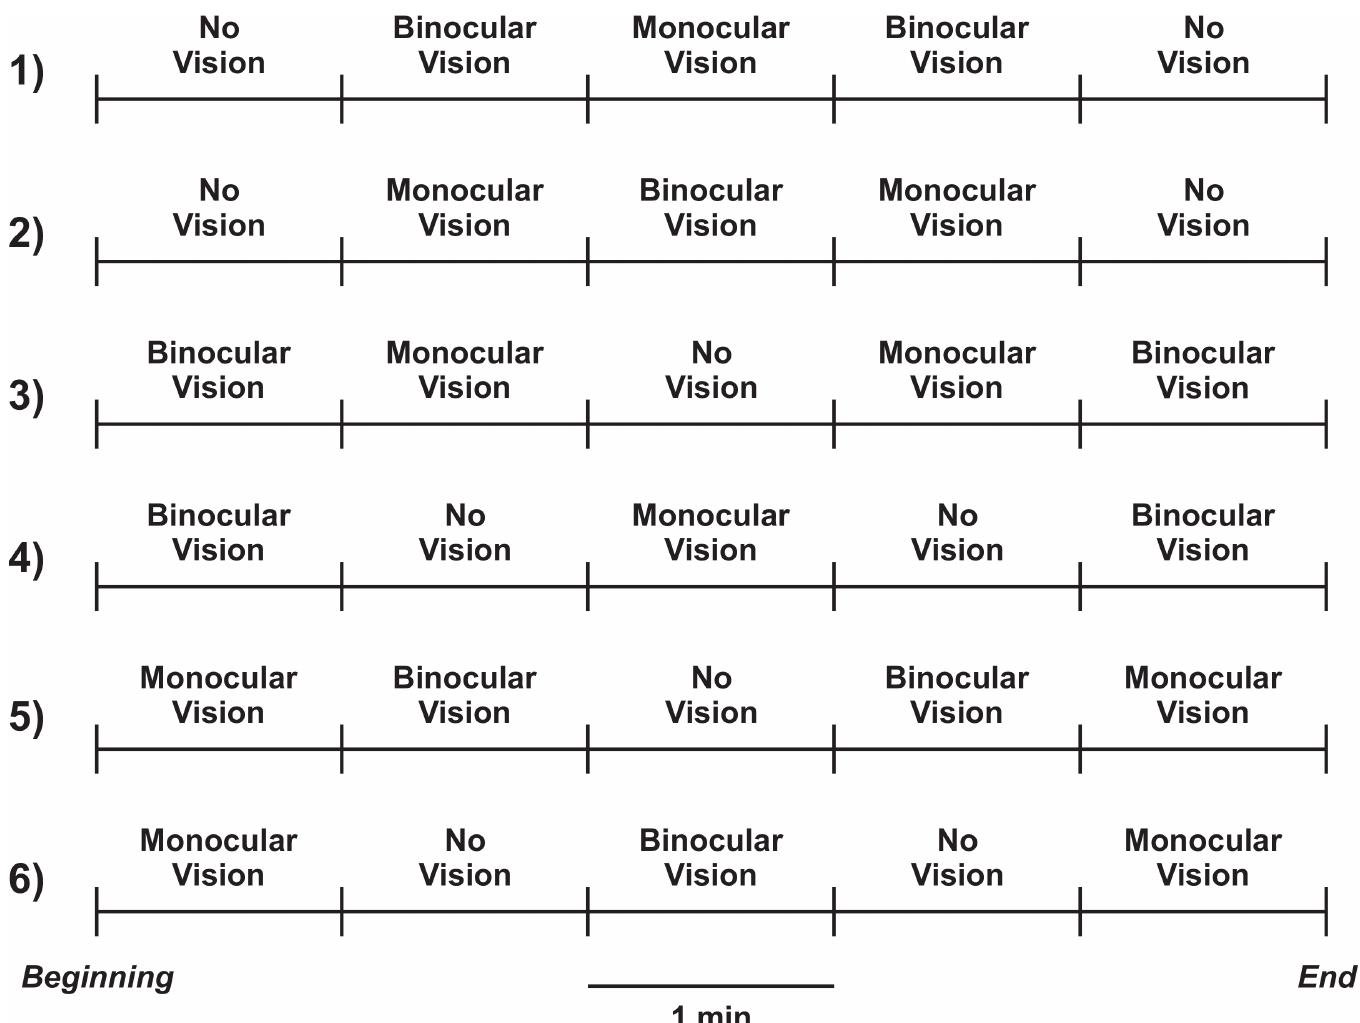
Fig 1. Illustration of the six visual conditions showing the lens status sequence. Each condition lasted five minutes (one minute for each lens status).